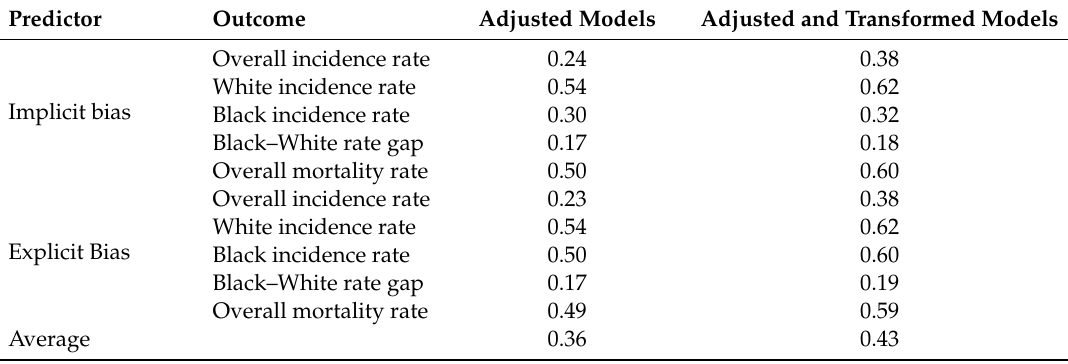
Table A2. R 2 values in adjusted versus adjusted and transformed models.